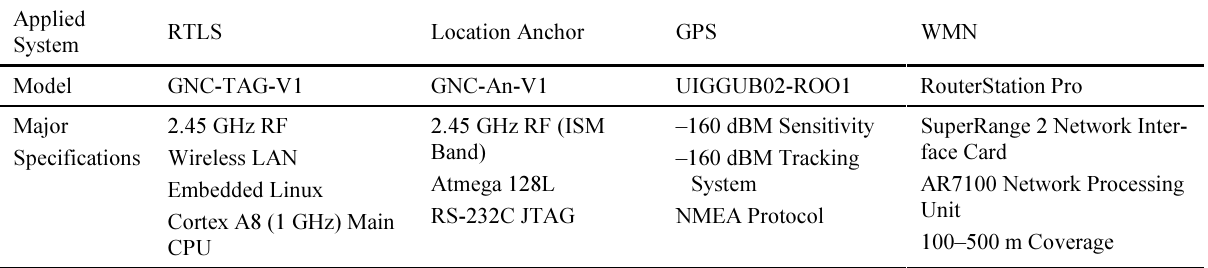
Fig. 7. Overall system application to the pilot project Table 4. System specifications applied in the pilot project